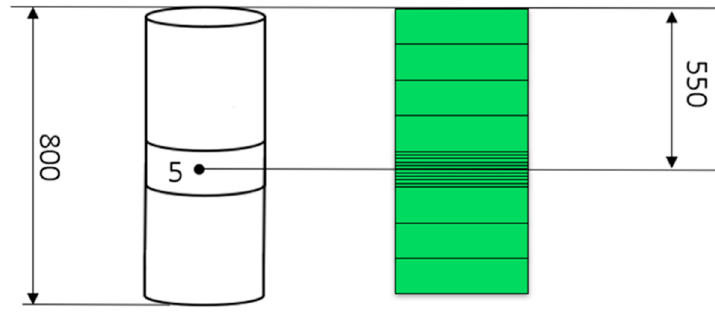
Figure 16. Reference node (#5) splitting for the investigation of the influence that node volume plays on model accuracy (heights in millimeters).